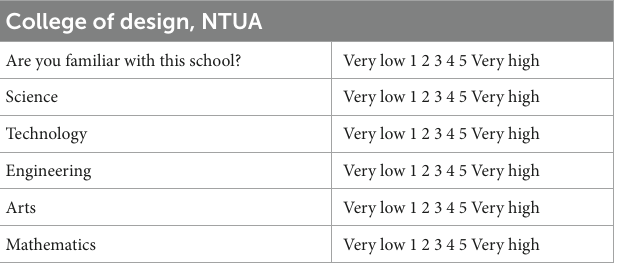
TABLE 2 The second part of the questionnaire (taking NUTA as